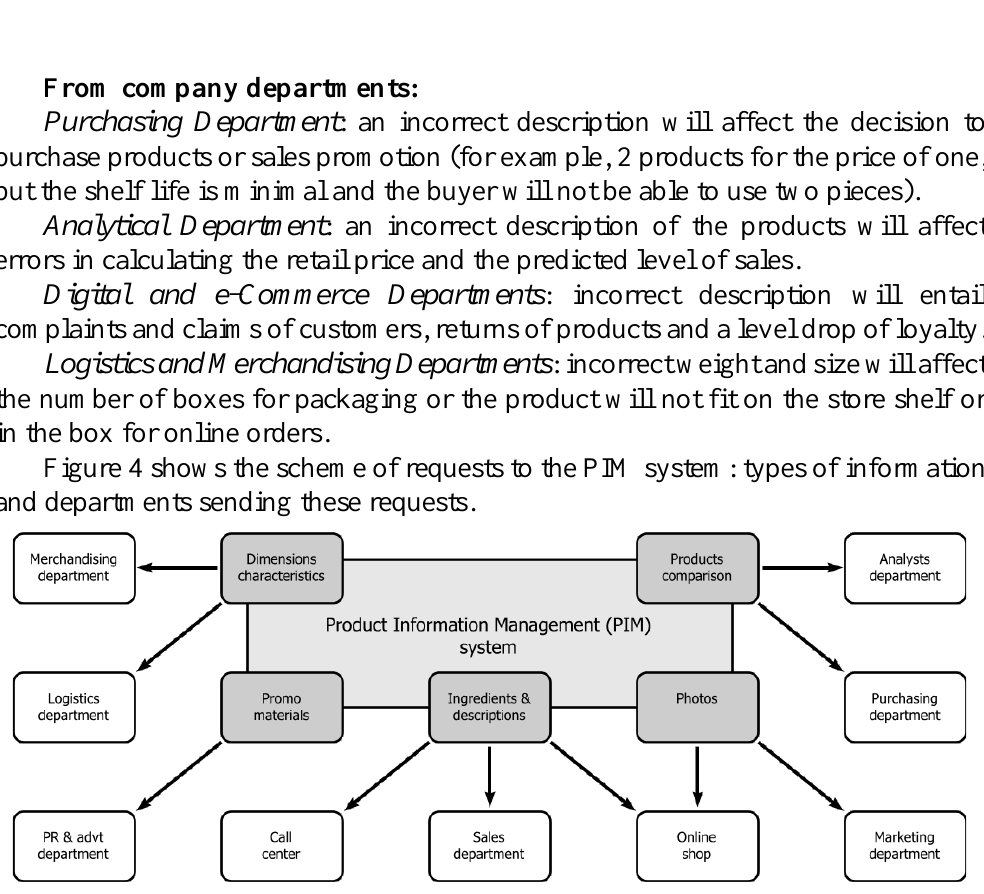
Fig. 4. Intracorporate scheme of information interaction (authors’ developed).